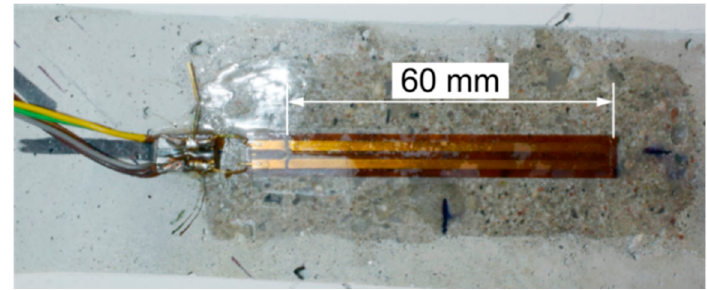
Figure 11. View of the glued strain gauge.